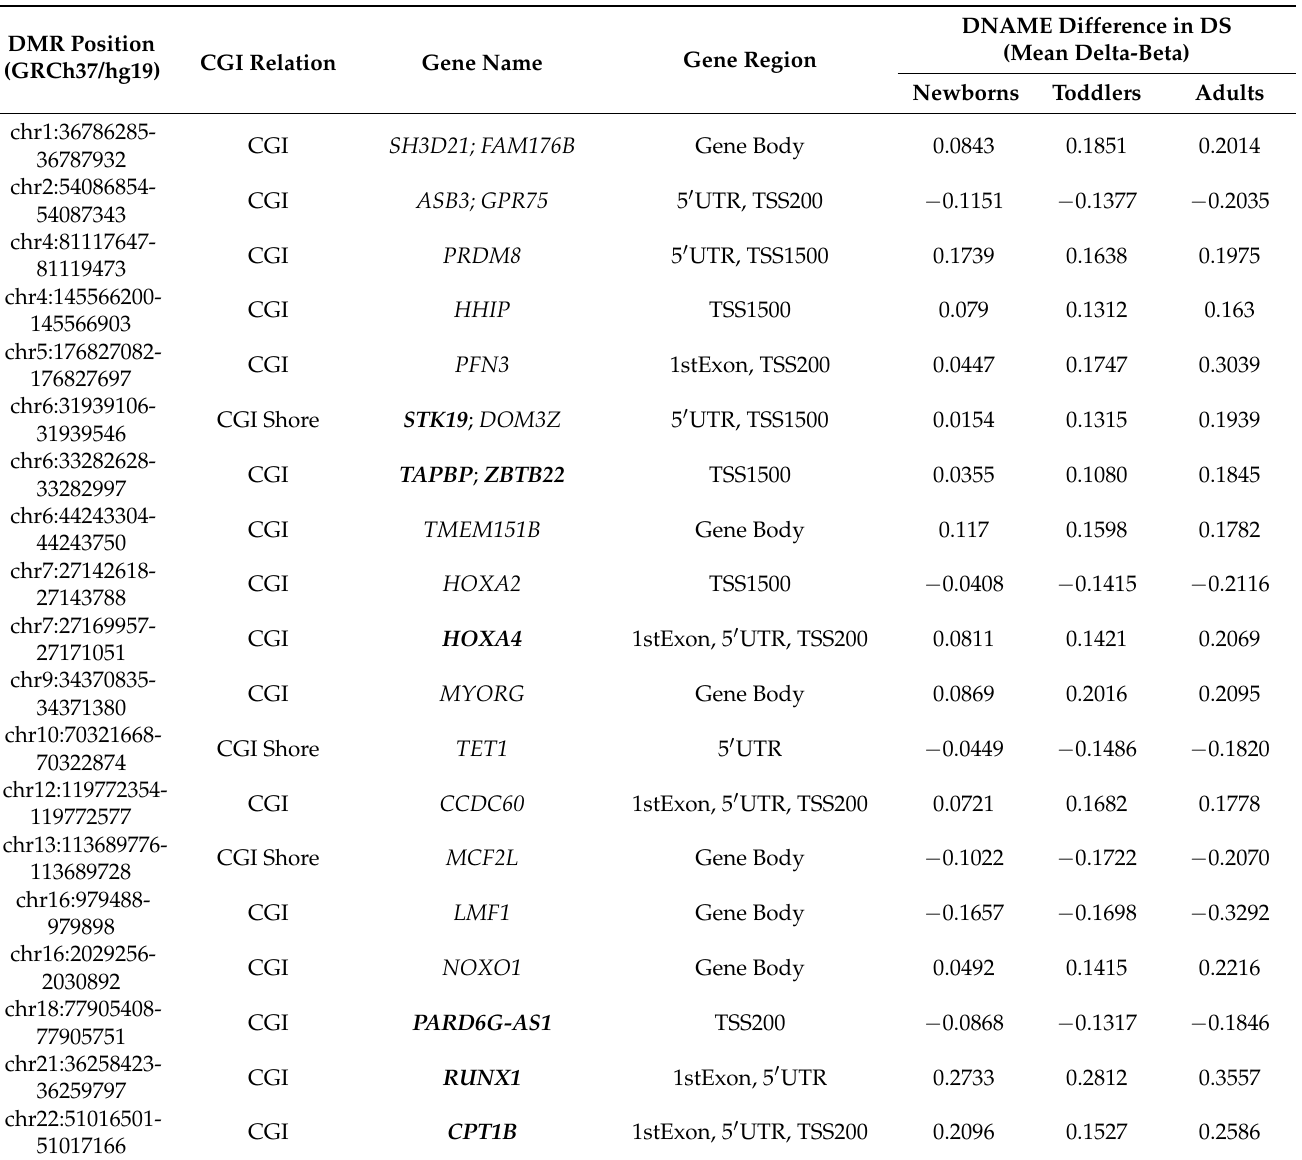
Table 5. The 19 Down syndrome-associated differentially methylated regions (DMRs) identified across all three age groups of individuals with DS: newborns [8], toddlers (current study), and adults [6]. Genes reported as having pan-tissue DS-associated methylation signals [3] are marked in